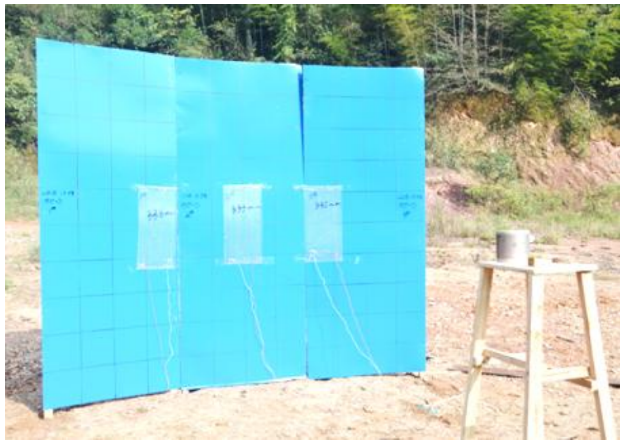
Figure 3. Sketch of the overall experimental